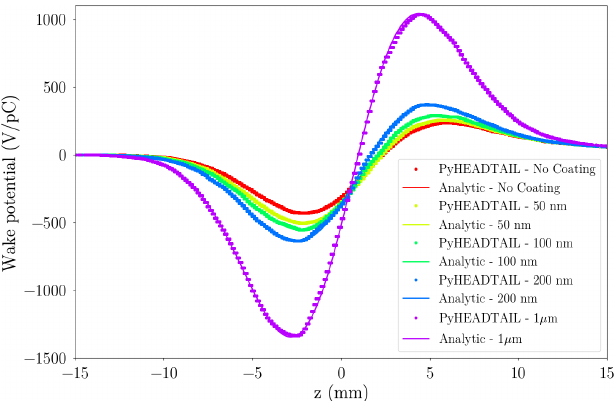
FIG. 4. Comparison of the analytical longitudinal wake poten- tials of a 3.5 mm Gaussian bunch with the wake potentials obtained from P Y HEADTAIL as convolution between the longi- tudinal bunch distribution and the wake potential of a 0.35 mm Gaussian bunch in the case of no coating with a copper pipe of 35 mm of radius, and with different thicknesses of coating